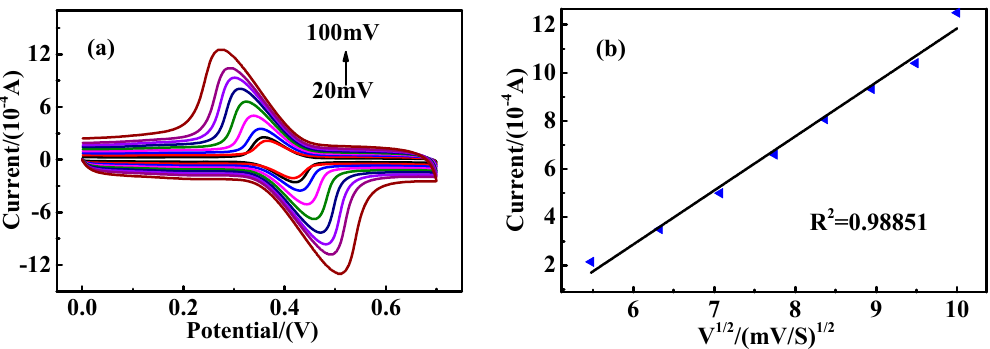
Figure 6. The cyclic voltammetry curve of ZCF-modified GCE in 1 mM hydroquinone solution with different scan rates (20 mV/s, 30 mV/s, 40 mV/s, 50 mV/s, 60 mV/s, 70 mV/s, 80 mV/s, 90 mV/s, and 100 mV/s) ( a ) the current varies with the scan rate; ( b ) the relation curve of oxidation peak current and v 1/2 .